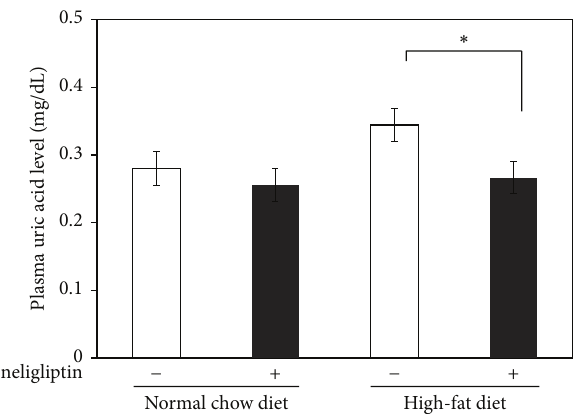
Figure 1: Effects of teneligliptin on plasma uric acid levels in male Wistar rats. The rats were fed with NCD or HFD with or without teneligliptin ( ∼ 4.0mg/kg body weight/day) for 4 weeks. After 4 weeks, the rats were fasted for 6 hours, and then plasma samples were obtained in the presence of EDTA-Na from the aorta of rats under anesthesia. The plasma uric acid levels were measured by a private laboratory ( ◻ , control group, NCD-fed rats: 𝑛 = 10 , HFD- fed rats: 𝑛 = 9 ; ◼ , teneligliptin group, NCD-fed rats: 𝑛 = 9 , HFD-fed rats: 𝑛 = 9 ). Data are the means ± SEM. ∗ 𝑃 < 0.05 versus the control